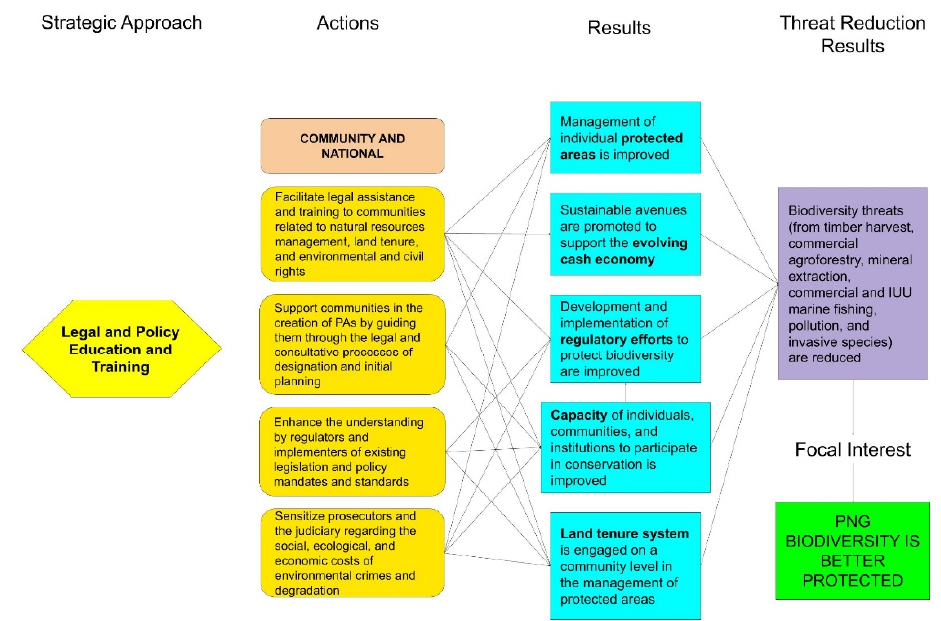
Figure 6. Results Chain for strategic goal of Legal and Policy Education and Training in Papua New